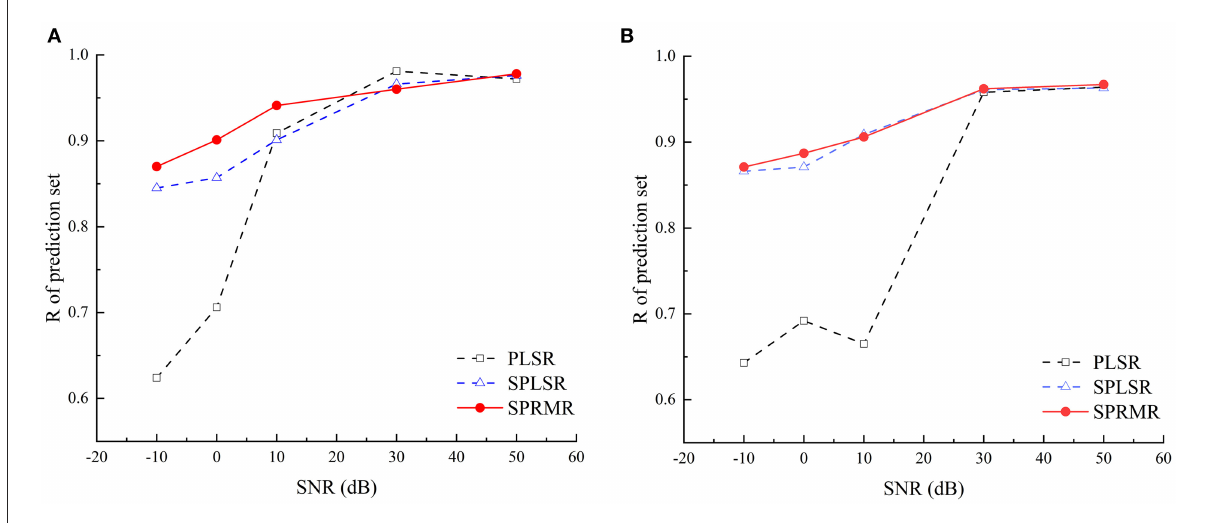
FIGURE5 The influence trends of WGN with different SNR on calibration correlation coefficient of three models. (A) The static detection; (B) The online detection.